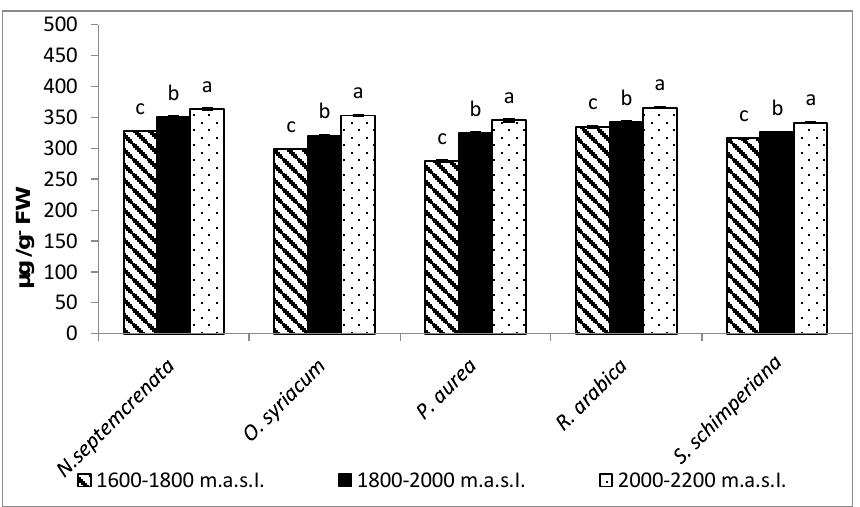
Figure 4. Effect of altitude on the total soluble proteins. Each value is the mean of three replicates ± SE. Bars with different letters are significantly different at p ≤ 0.05.